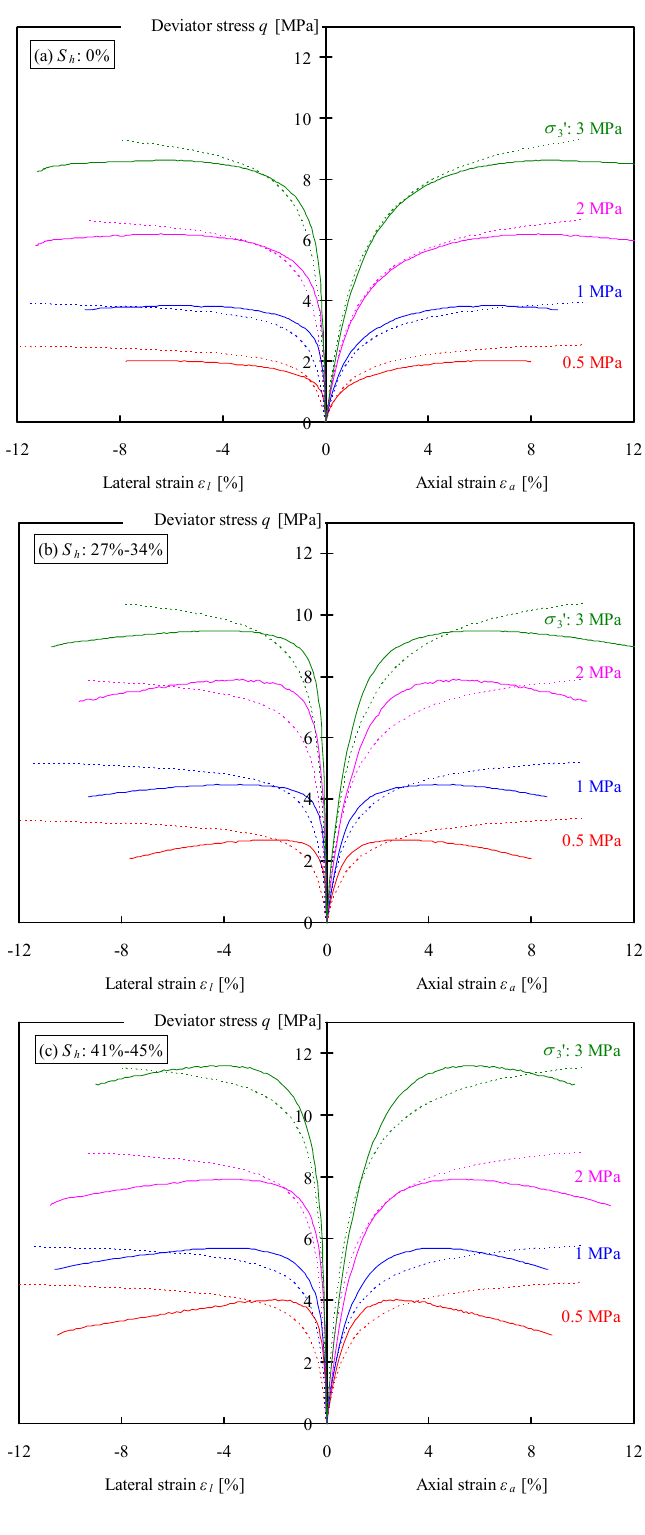
Figure 1. Experimental (solid lines) and calculated (broken lines) deviator stress q versus axial strain ε and lateral strain ε for specimens formed by Toyoura sand with methane a l hydrate saturation S of ( a ) 0%; ( b ) 27%–34% and ( c ) 41%–45%. Experimental results are h taken from the reference